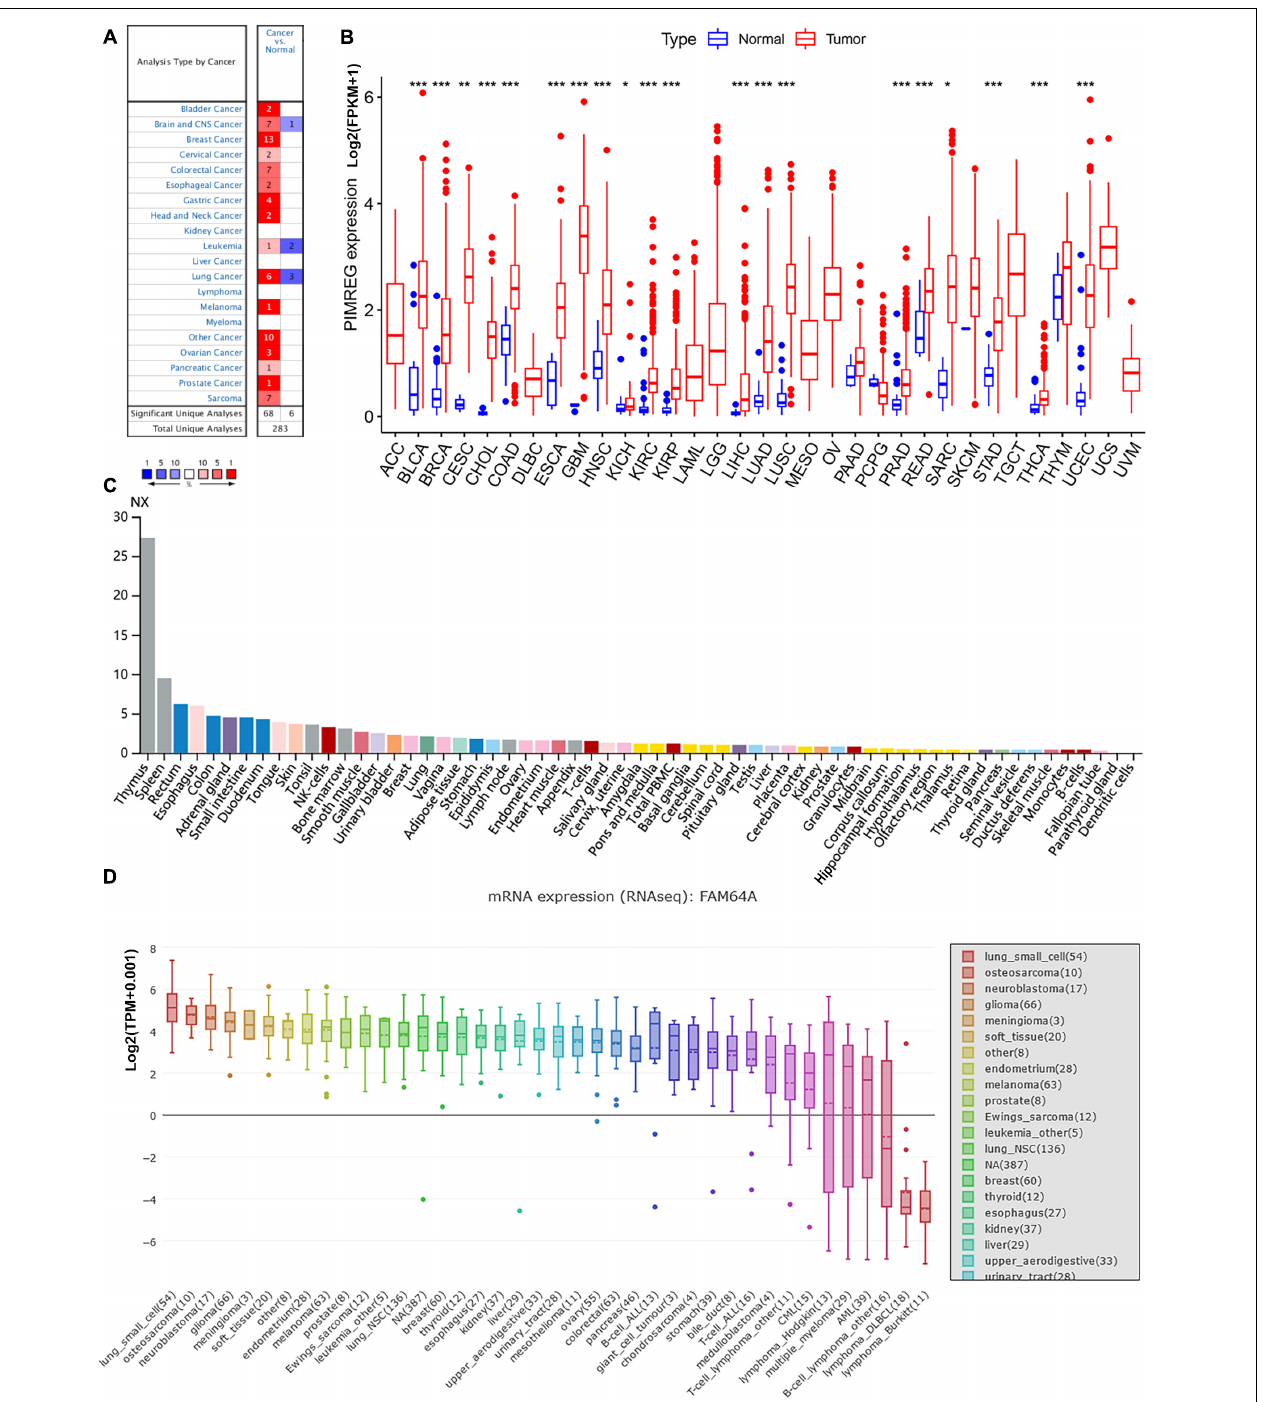
FIGURE 1 | Different expression between normal and tumors tissues. (A) PIMREG gene expression is increased in major tumor tissues compared to normal tissues. The number in each small rectangle represents the number of data sets with high or low expression of the PIMREG gene in each cancer. The red and blue shades indicate the proportion of data sets with high or low expression of PIMREG in each cancer tissue, respectively. The numbers 68 and 6 in the small white box represent the total number of data sets with high and low expression of PIMREG gene in cancer tissues, and 283 represents the total number of all data sets included. (B) Different PIMREG expression levels in various tumor and normal tissues. (C) Different protein levels of PIMREG in various organs. Consensus Normalized expression (NX) levels for 55 tissue types and 6 blood cell types, created by combining the data from the three transcriptomics datasets (HPA, GTEx and FANTOM5) using the internal normalization pipeline. (D) mRNA expression of PIMERG in different cell lines. * p < 0.05, ** p < 0.01, and *** p < 0.001.